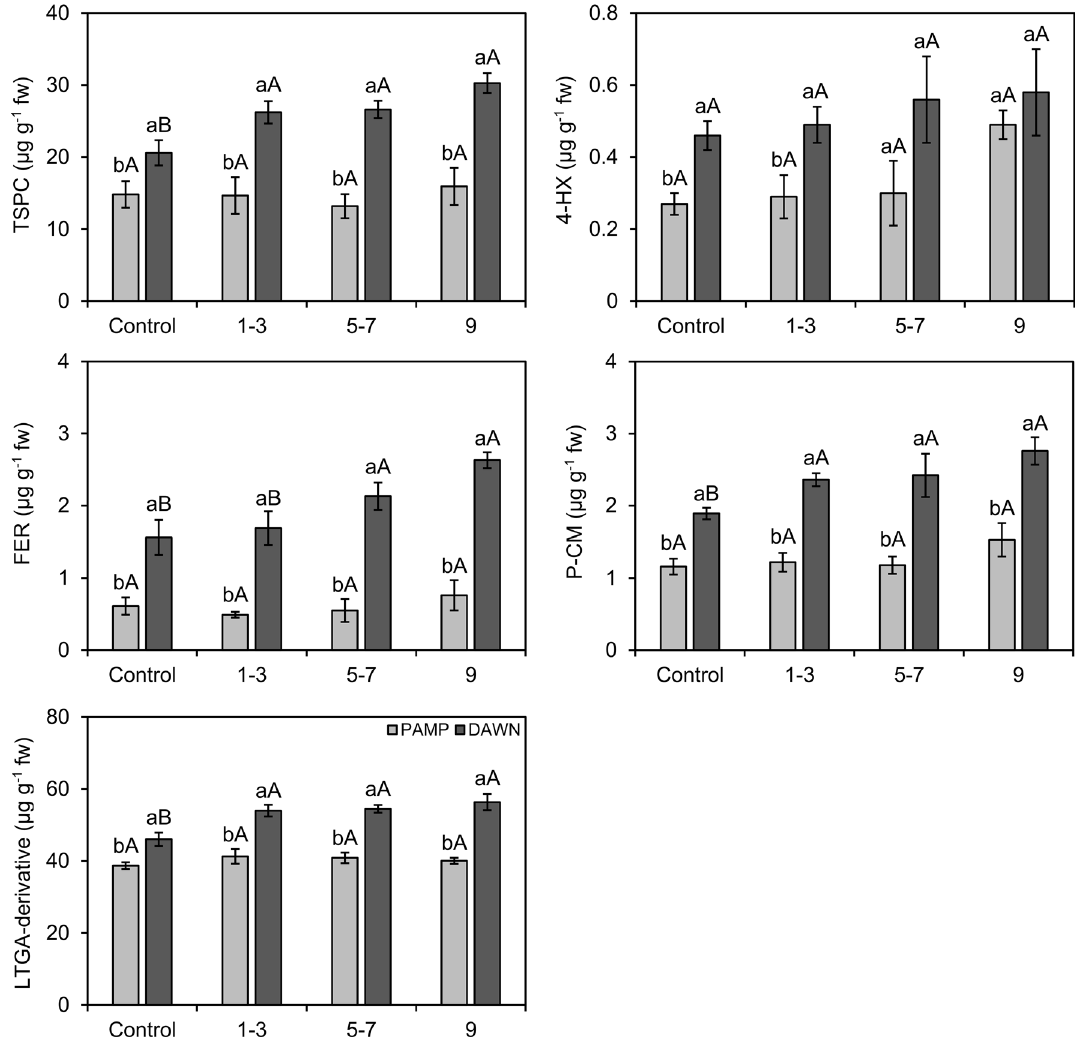
Figure 7. Concentrations (± SE) of total soluble phenolic compounds (TSPC), 4-hydroxybenzoic (4-HX), ferulic (FER), and p -coumaric (P-CM) phenolic acids, and lignin-thioglycolic acid (LTGA) derivatives in rice roots from susceptible (Ss) and resistant (Rr) cultivars with different levels of natural infestation of the South American rice water weevil Oryzophagus oryzae at 25 days after flooding (DAF). Rice cultivars: PAMP = BRS Pampa CL (Ss) (light gray columns); DAWN = Dawn (Rr) (dark gray columns). Levels of natural infestation of larvae on plants selected for biochemical analysis at 25 DAF (larvae infestation peak in the field) = 1 (control): 0 larva; 2: 1–3 larvae; 3: 5–7 larvae; 4:9 larvae. Different lowercase letters above bars denote significant differences among rice cultivars at each infestation level, whereas different uppercase letters above bars denote significant differences in the same rice cultivar among infestation level, both by the Scott Knott test ( P ≤